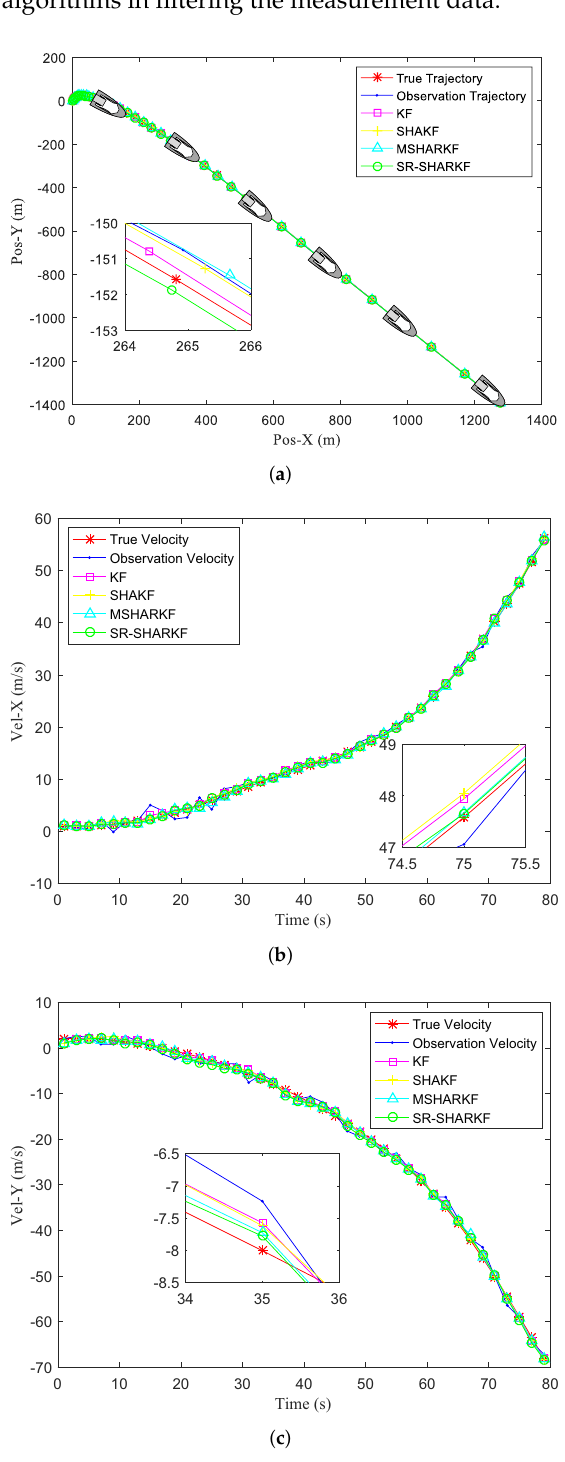
Figure 6. Filtering effect in terms of position and velocity. ( a ) Target trajectory. ( b ) Target velocity in the X-axis direction. ( c ) Target velocity in the Y-axis